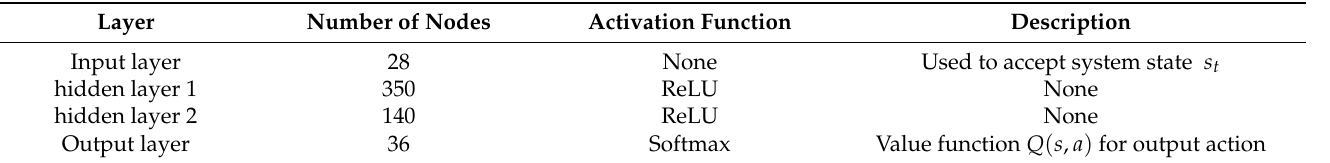
Table 2. Network parameter settings.